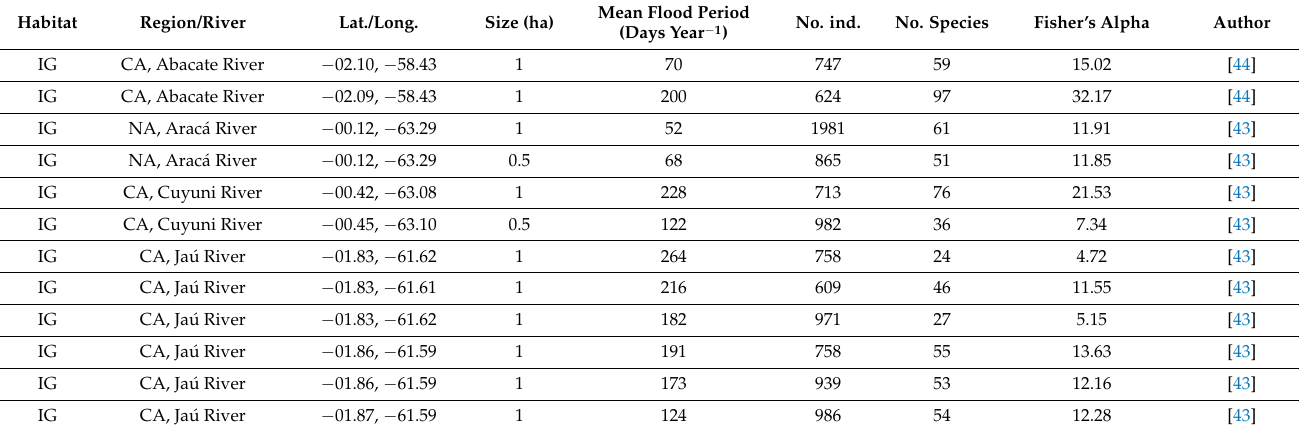
Table 1. Metadata of the floristic inventories used for the comparison of Amazonian igap ó (IG) and v á rzea (VZ) forests, including habitat type, river and geographic coordinates, plot size, plot mean flood period, number of inventoried individuals and species, Fisher’s alpha diversity index, and publication authors. Total inventoried area sums up to 28.75 ha in igap ó and 28.875 ha in v á rzea forests. CA = Central Brazilian Amazon, NA = Northern Brazilian Amazon, WA =